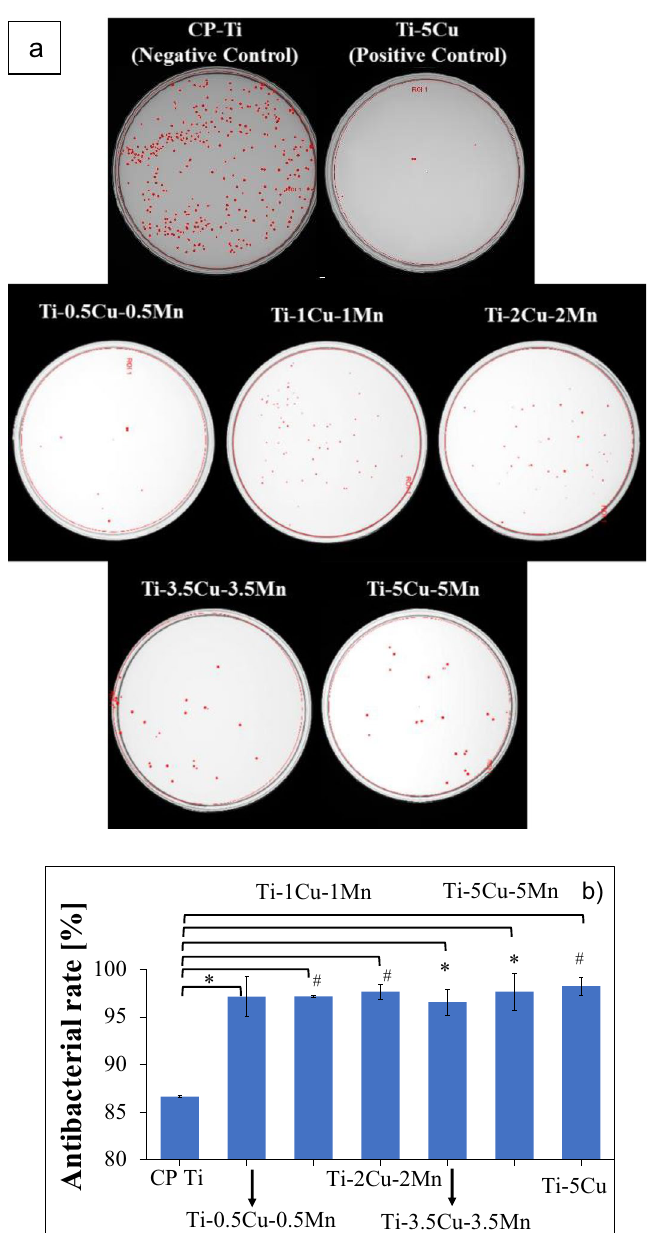
Figure 6. Representative photographs of the E. coli bacterial colonies after 24 h incubation for β eutectoid bearing functionalised Ti alloys, ( a ) CP Ti (positive control), and Ti–5Cu (negative control) specimens, and ( b ) respective in vitro antibacterial rate using E. coli culture. Note : *p < 0.05 and #p <